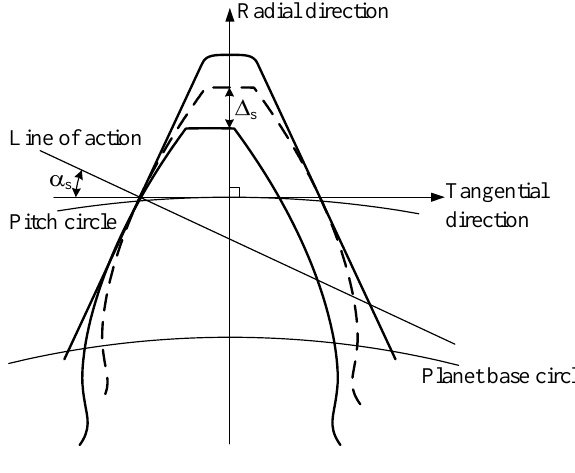
Figure 6: The tooth positions for drive-side contact (solid line) and tooth wedging (dashed line), see Guo and Parker (2010).